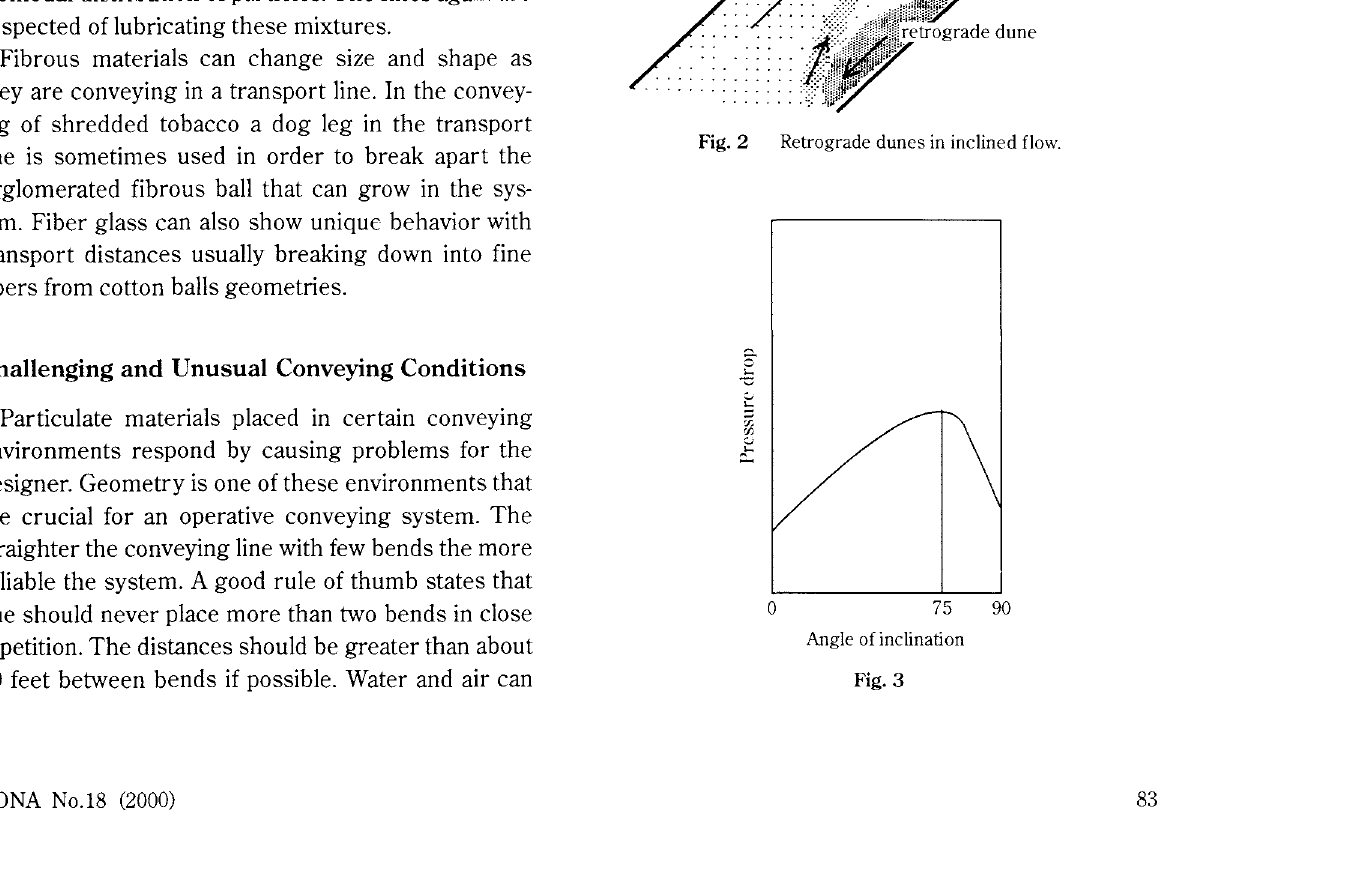
Retrograde dunes in inclined